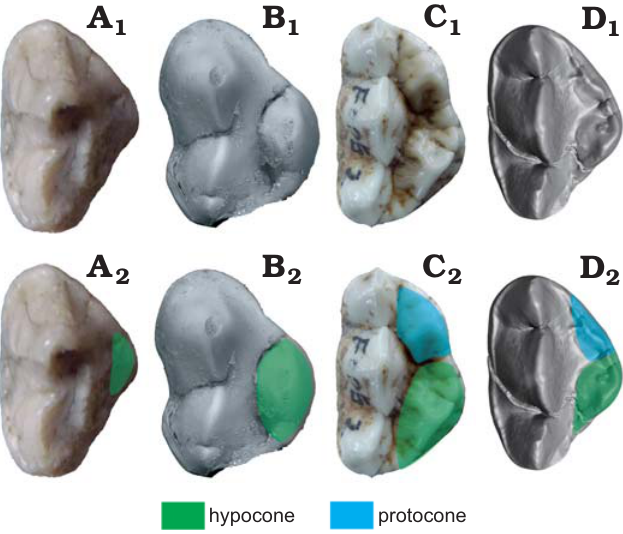
Fig. 3. Occlusal views of P4 homologous structures in cave bear (A, B) and giant panda (C, D) lineages. A . Ursavus tedfordi Qiu, Deng, and Wang, 2014 (HMV1453) from Huaigou, Gansu Province, Late Miocene. B . Ursus deningeri Von Reichenau, 1904 (NMM1946/643, photo Jan Wagner) from Mosbach 2, Germany, early Middle Pleistocene. C . Ailuro poda sp.